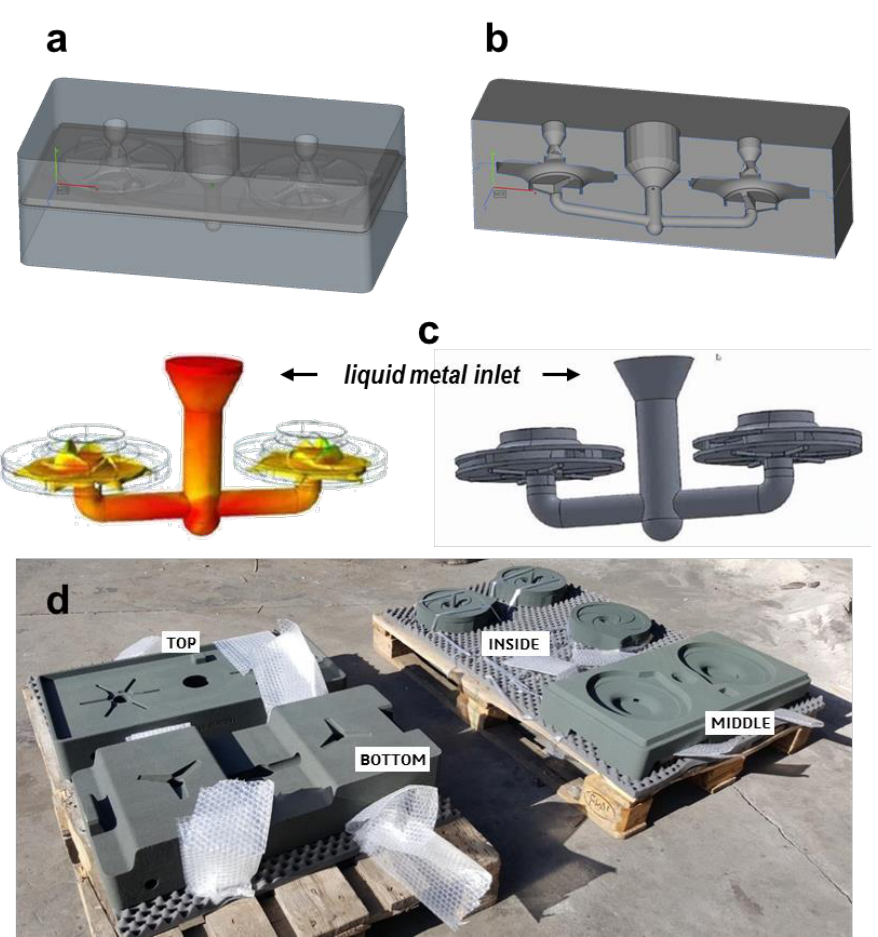
Figure 6. ( a ) Transparent and ( b ) cross-section 3D views of the sand moulds. ( c ) Model views of the impeller fills at the initial (left) and final (right) moments. ( d ) Photographs of the manufactured 3D sand moulds indicating the different parts.